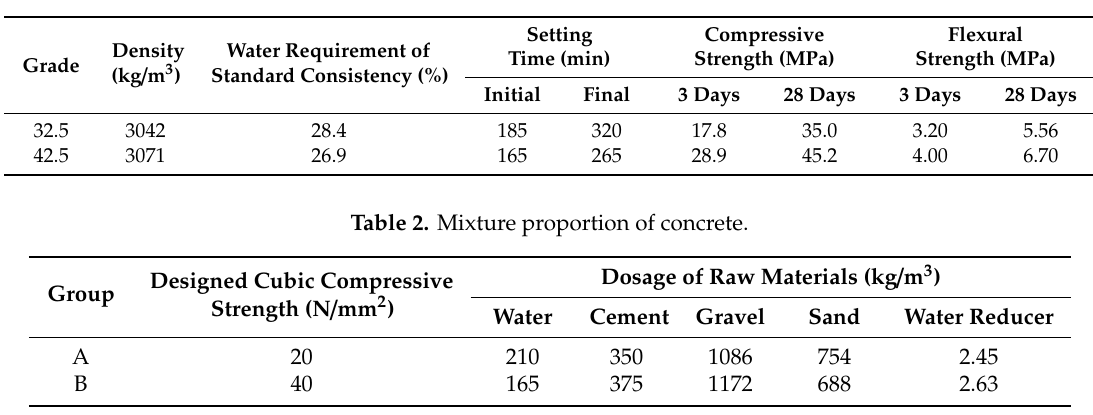
Figure 3. Specimens cured under water in tank.